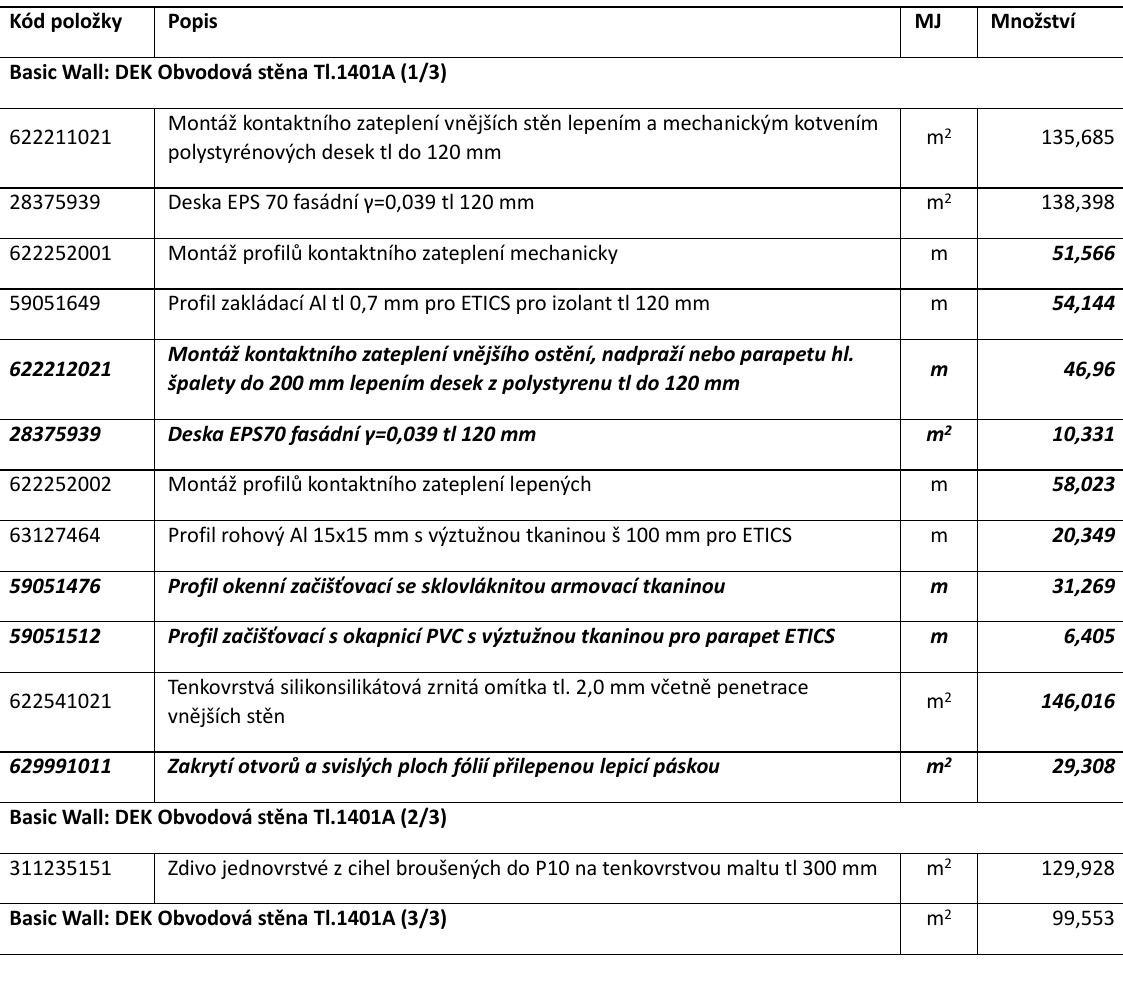
Basic Wall: DEK Obvodová stěna Tl.1401A